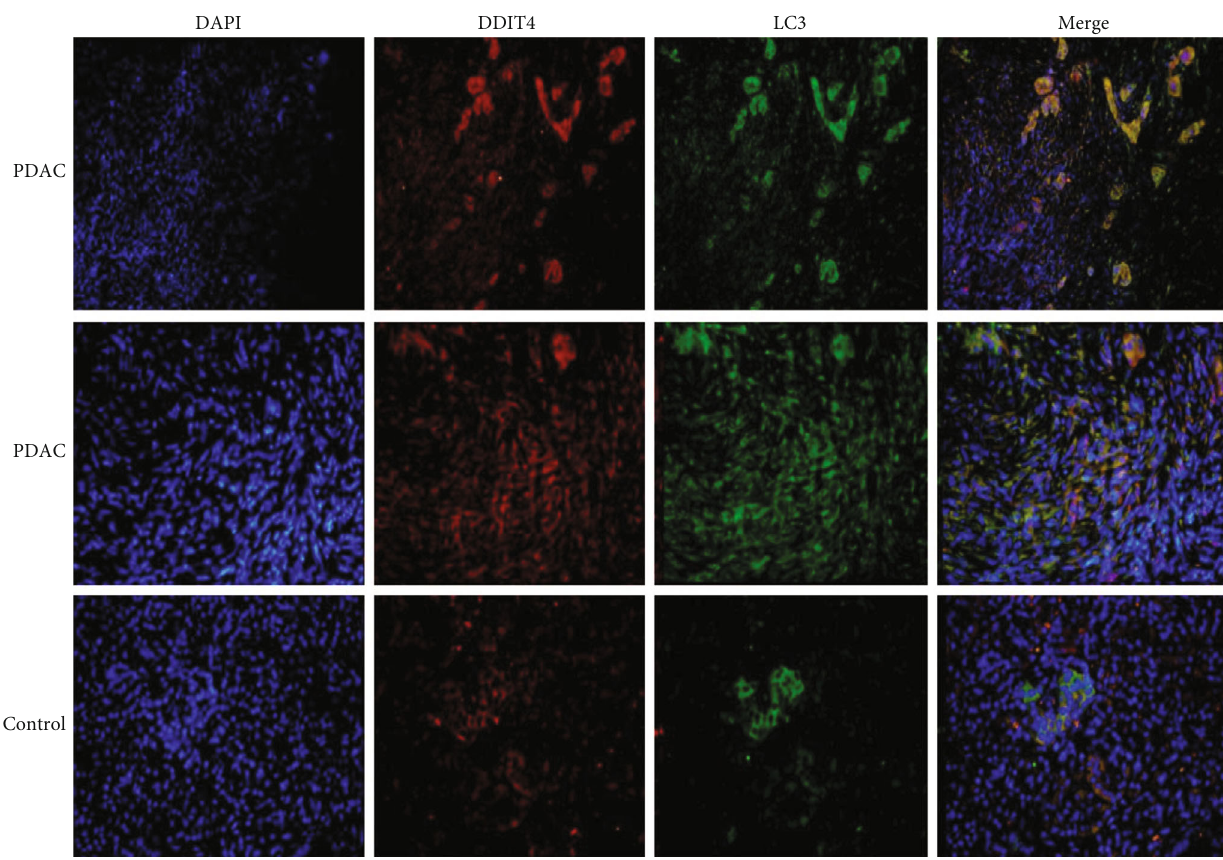
Figure 3: Fluorescence showed the distributions of DDIT4 and LC3 in pancreatic cancer